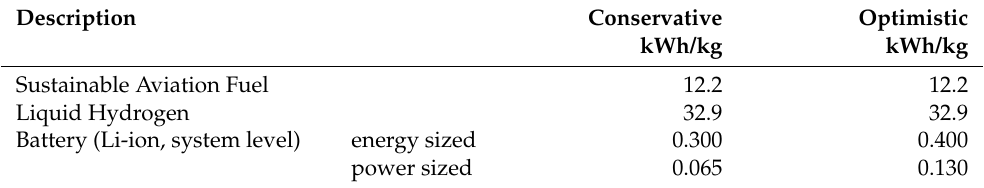
Table A2. Assumed specific energies of energy storage systems.